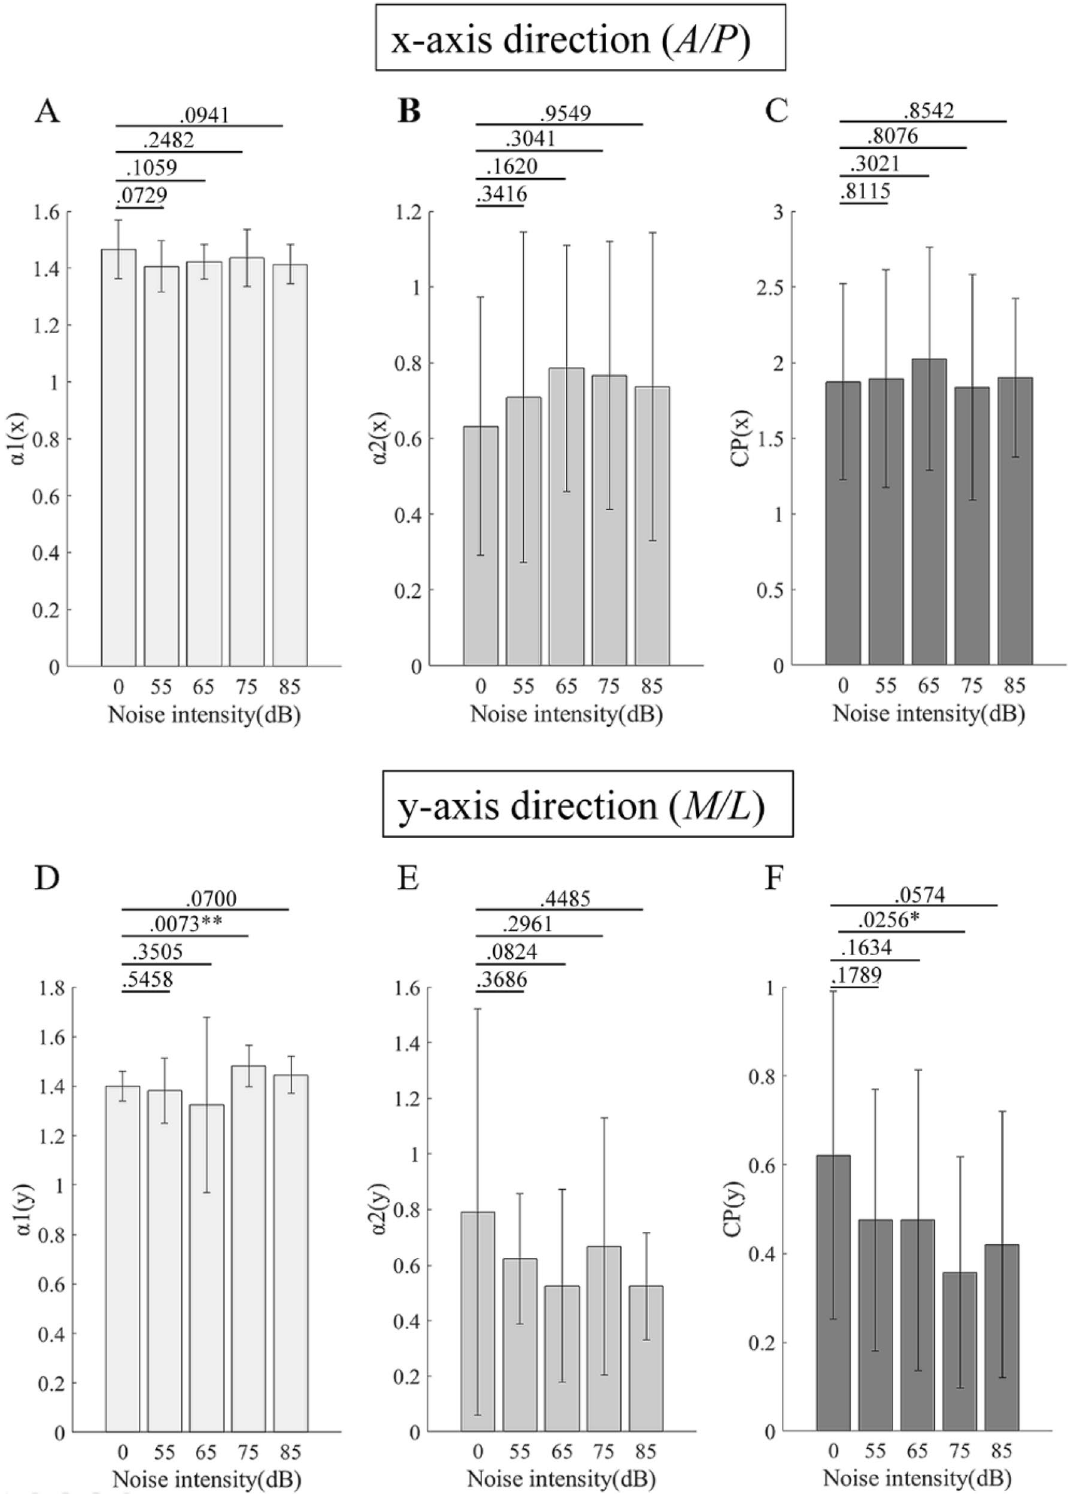
Figure 2. Fractal characteristics data of DFA stimulated with different WGN intensities. ( A – C) are the data at the x-axis ( A/P ) direction; ( D – F) are the data at the y-axis ( M/L ) direction. ( A ) Short-term scaling index. ( B ) Long-term scaling index. ( C ) The intersection point between short-term and long-term fluctuations. ( D ) Short-term scaling index. ( E ) Long-term scaling index. ( F ) The intersection point between short-term and long- term fluctuations. Data are presented as average ± standard deviation (SD); *means P < 0.05; **means P < 0.01. A/P = anterior/posterior; M/L = medial/lateral; CP = crossover point. Data of the images (A-F) were processed using Matlab (R2017a, https ://www.mathw orks.com/produ cts/new_produ cts/relea se201